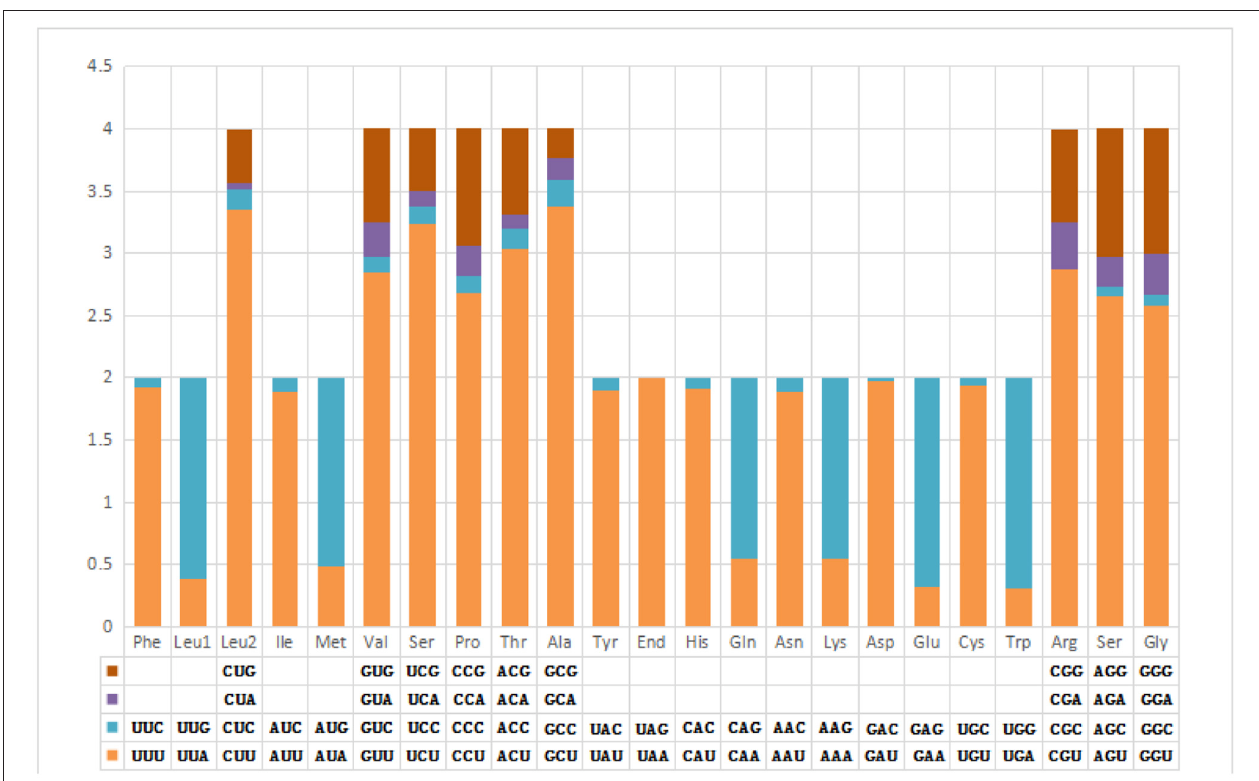
FIGURE 3 | Relative synonymous codon usage in F. intermediate mitogenome.